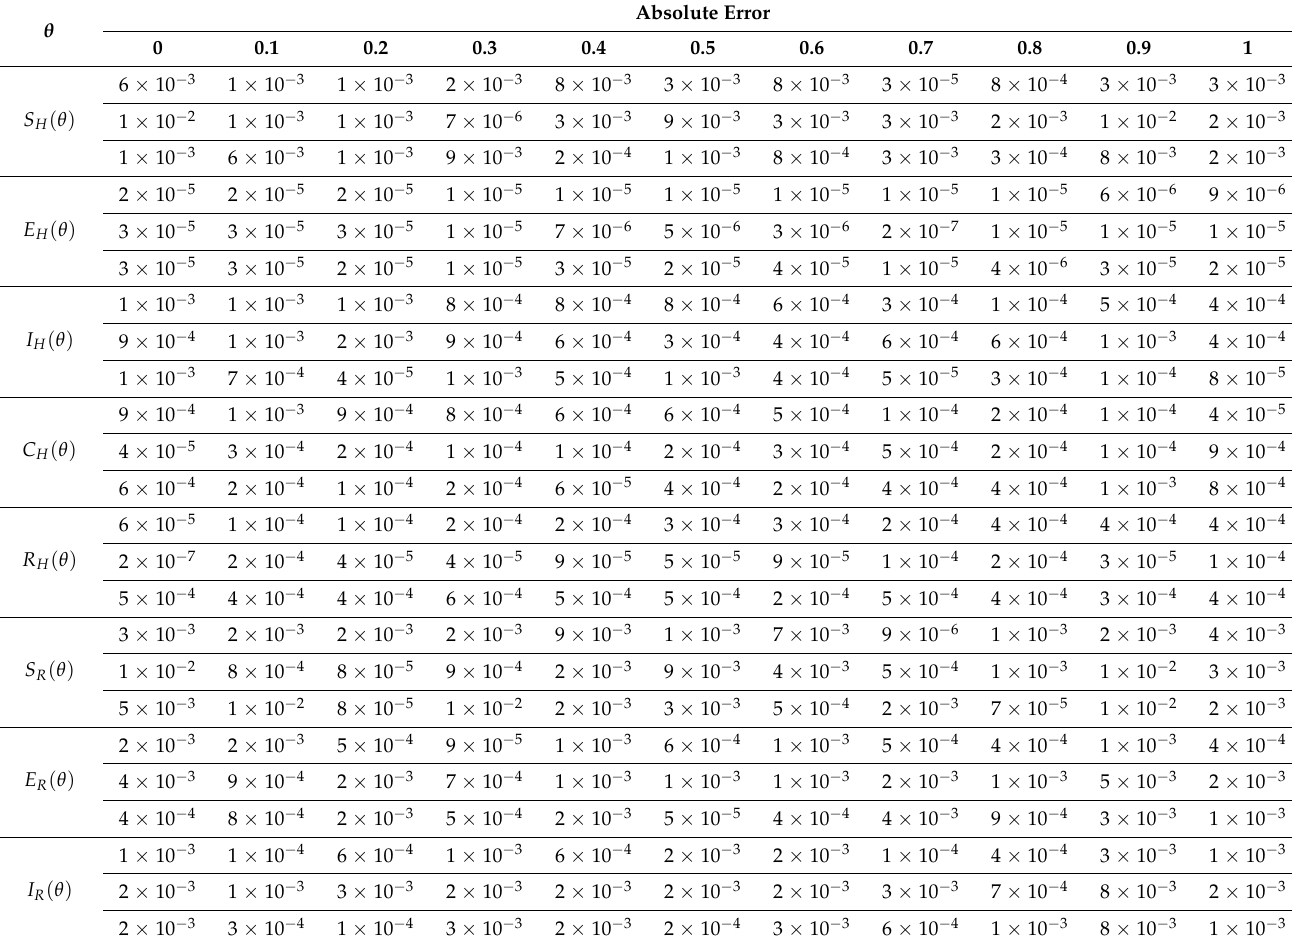
Table 3. AE for each category of the nonlinear